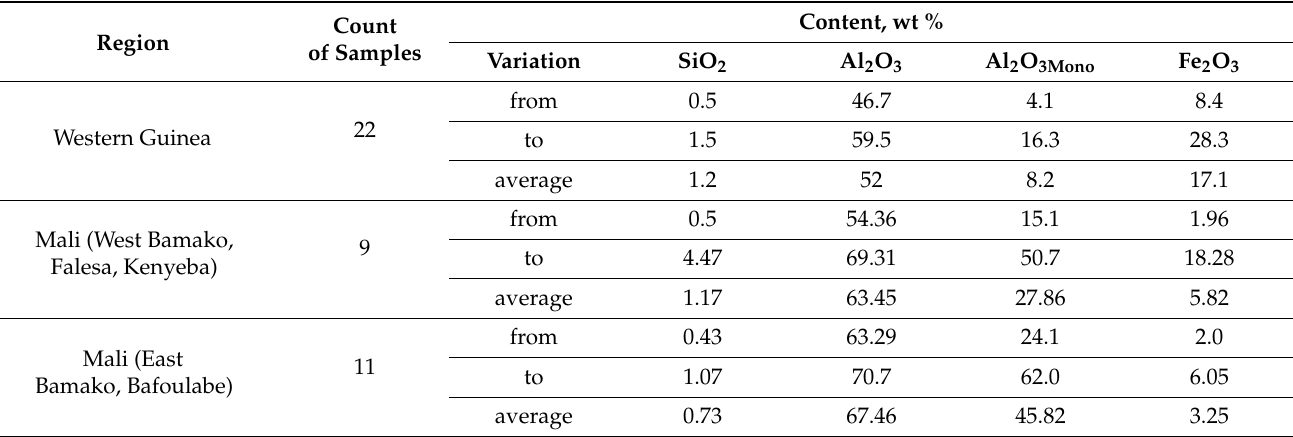
Table 3. Data on the first meter of geliform bauxite the Middle-Late Miocene regions of Western Guinea and Mali.